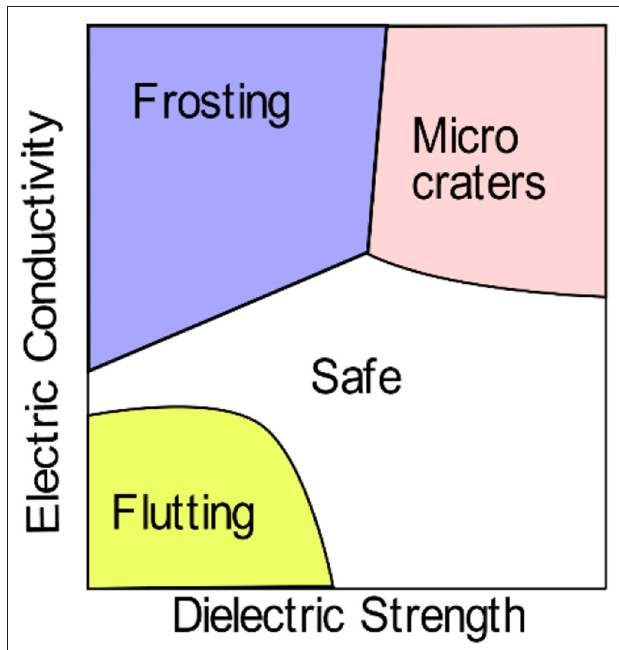
FIGURE 7 | The relationship between lubricant electric properties and bearing